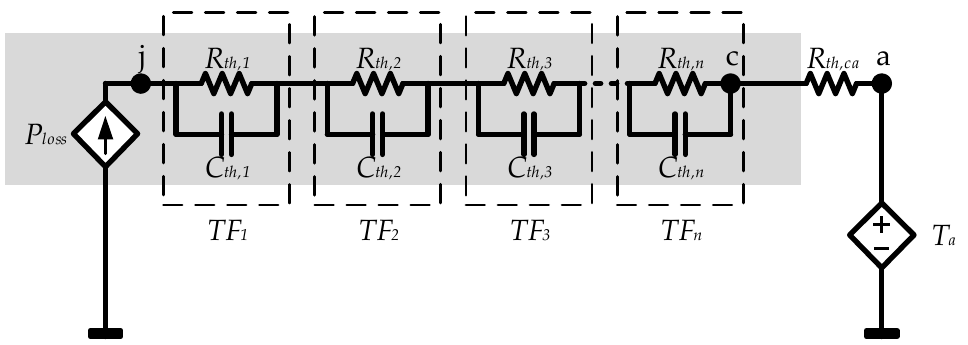
Figure 16. n layer semiconductor’s Foster circuit, where each pair of RCs can be transformed into a transfer function.